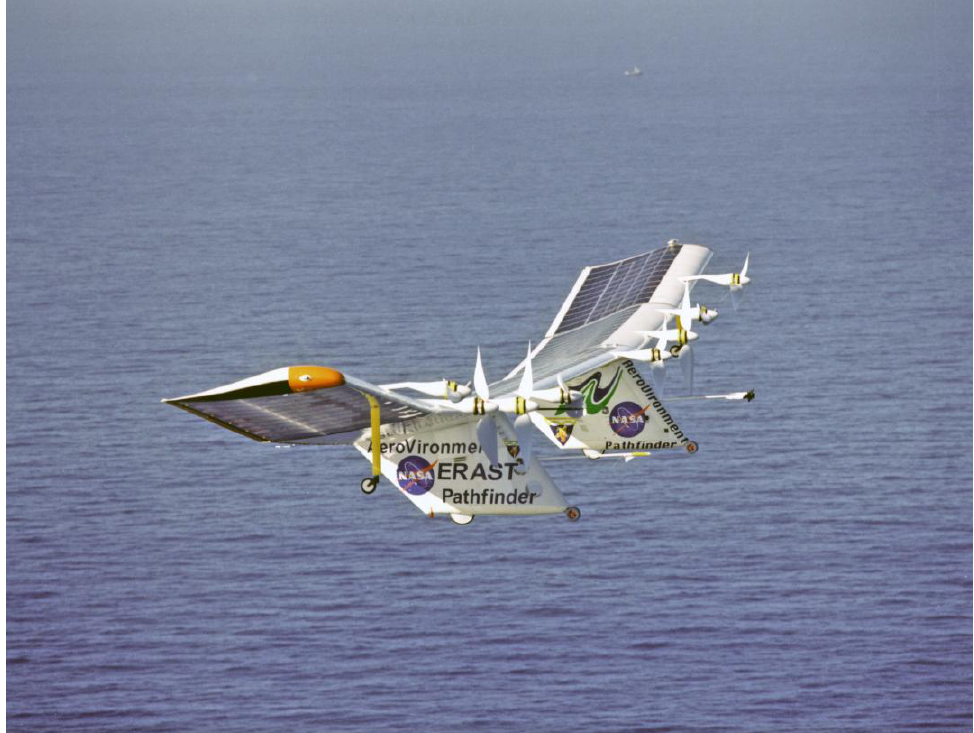
Figure 10. The Pathfinder HALE UAS. Image Courtesy